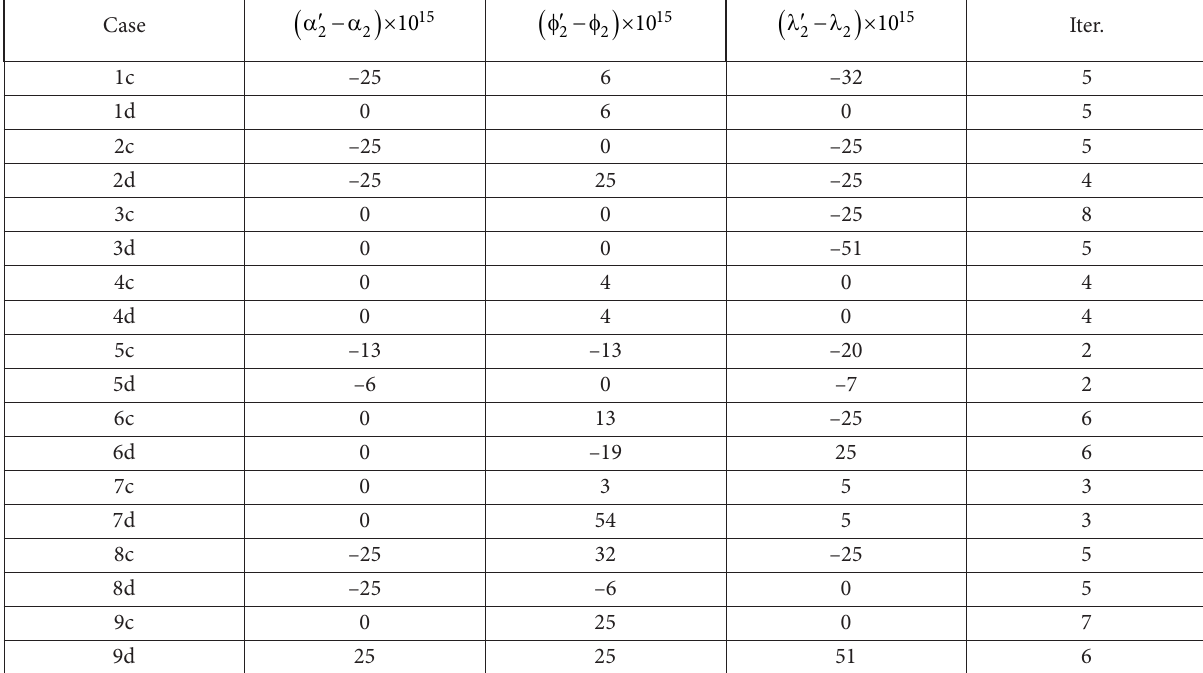
Table 6. Consistency of the inverse and direct problem. Values 12 α , 2 α and 12 s are calculated with the inverse algorithm; 2 ′α , 2 ′f